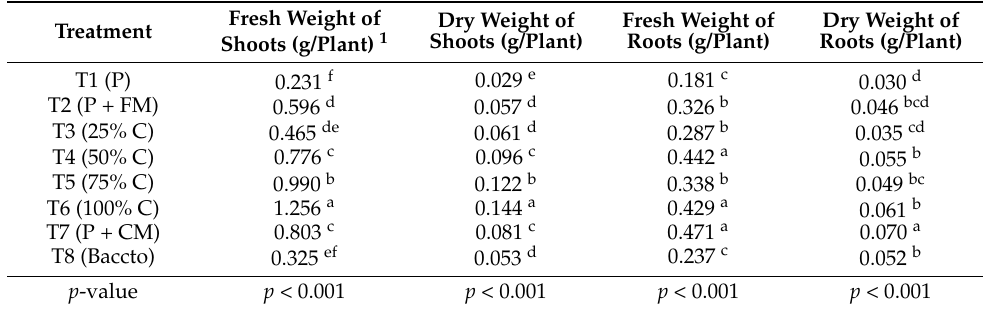
Table 2. Effect of different potting media treatments on the weight of beet seedlings, 36 days following seeding ( n = 5).